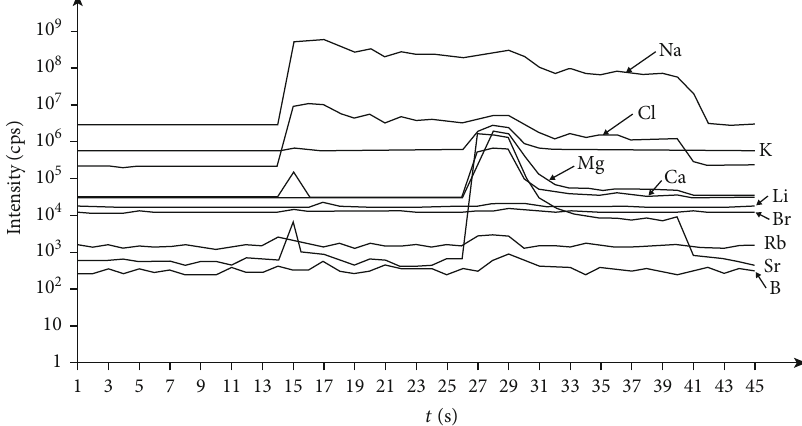
Figure 4: Mass spectral signal intensity versus time for a single fl uid inclusion in halite (no. 4 fl uid inclusion from